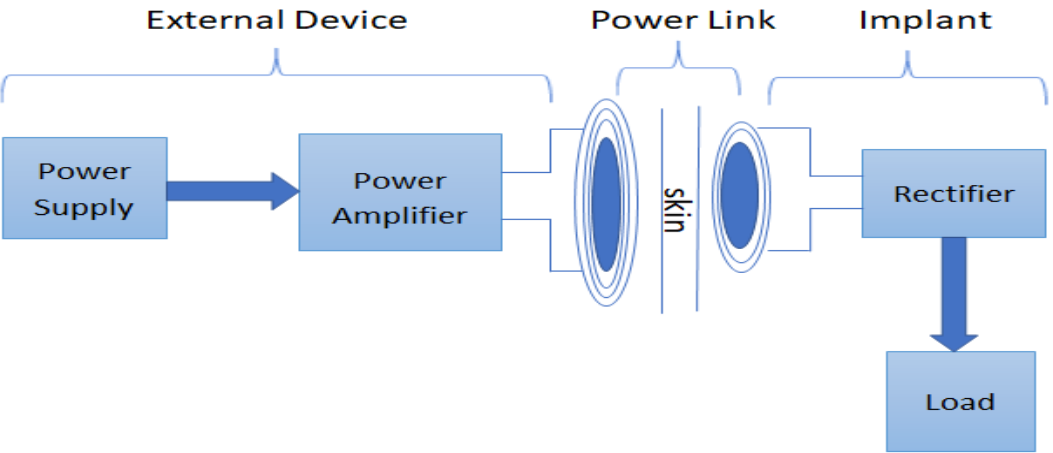
Figure 1. Basic WPT model.